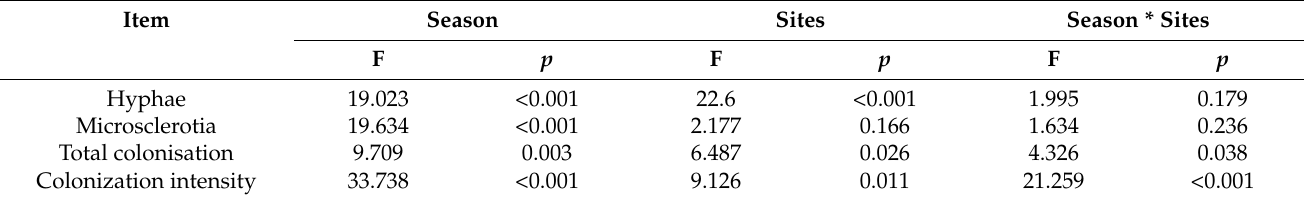
Table 1. Two-way analysis of variance of the effects of different seasons and sites on DSE colonization. Item